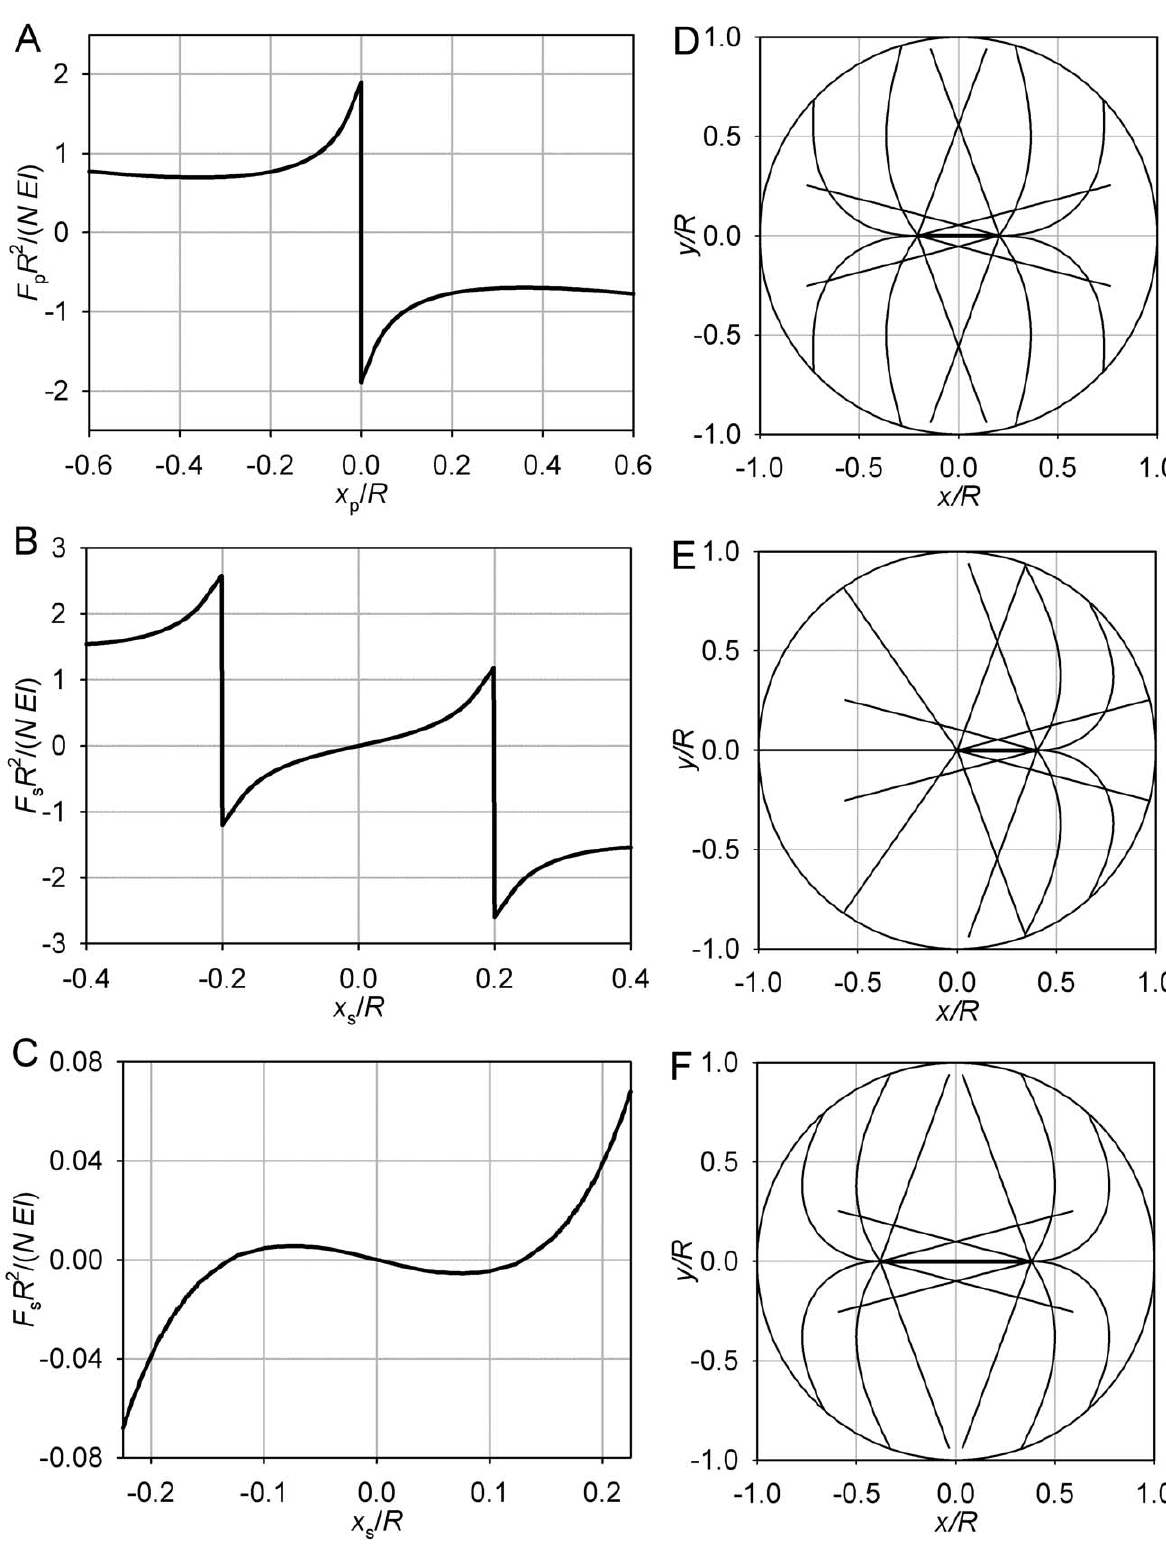
Figure 7. Special case of L = R , h max = p . (A) Pole force function. (B) Spindle force function, S =0.4 R . (C) Spindle force function, S =0.75 R . (D) Unstable symmetric equilibrium, S =0.4 R . (E) Stable asymmetric equilibrium, S =0.4 R . (F) Stable symmetric equilibrium, S =0.75 R . Plotting conventions as in Fig. 3.